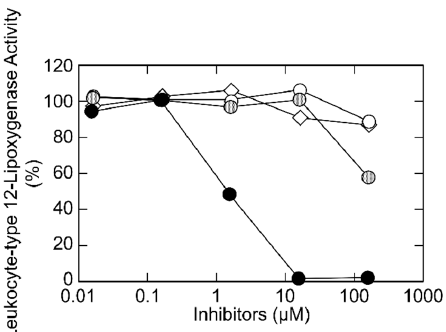
Figure 5. Inhibition of the leukocyte-type 12-lipoxygenase activity by liguroside A (closed circles), kudingoside B (grey circles), kudingoside A (open circles), and lipedoside B-III (open lozenges). Leukocyte-type 12-lipoxygenase was incubated with 25 μ M arachidonic acid, at 30 °C, for 5 min, in the standard reaction mixture in the presence of inhibitors, at various concentrations, and the products were quantified using a reverse-phase HPLC. Relative enzyme activities, as compared with the activity without inhibitors, are shown.